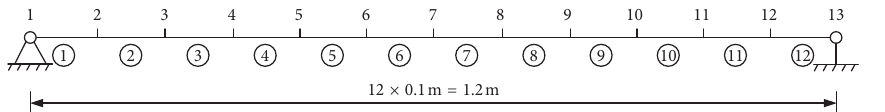
Figure 1: The finite element model of simply supported beam.